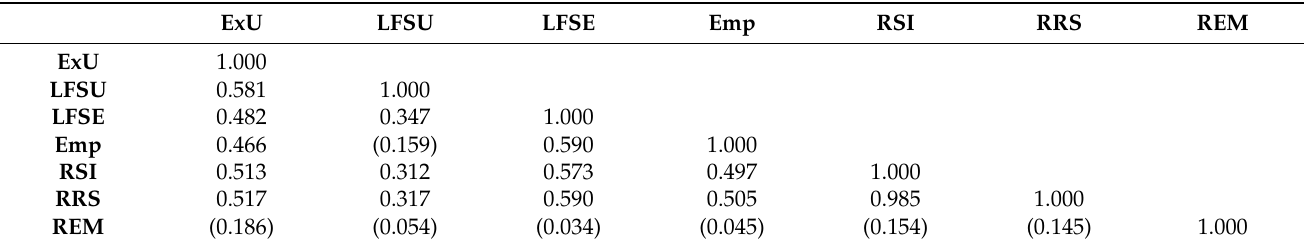
Table 1. Coherence matrix at frequency ω = 0.25.